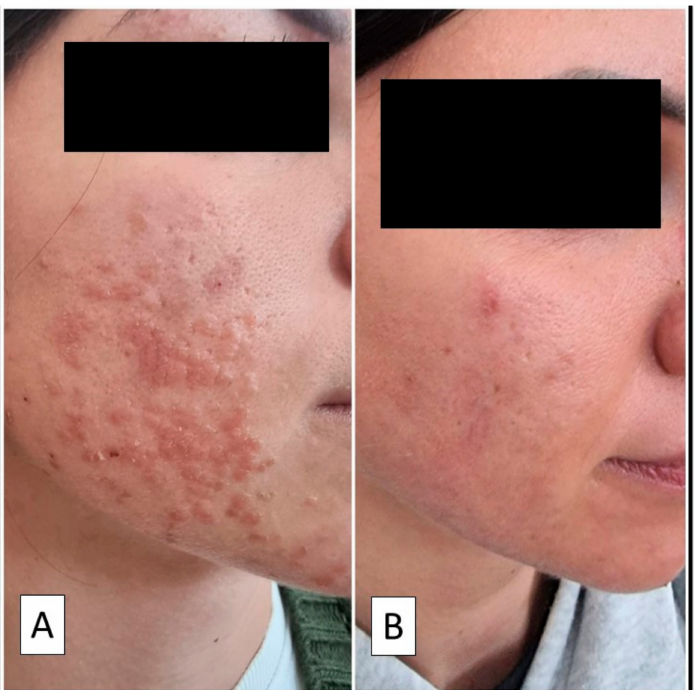
Figure 1. ( A ) Clinical photograph showing papular lesions, partly confluent in plaques, on the cheeks. ( B ) Almost complete remission of the lesions after two peeling sessions with 60% salicylic acid. The sample was fixed in neutral formaldehyde buffered at 10% and sent to the Com- plex Operative Unit of Anatomy and Pathological Histology of the same hospital. After sampling, processing, microtome cutting and drying under a hood, preparations stained with hematoxylin/eosin were prepared and observed under an optical microscope. Histo- logically, a zone of acanthosis with hypergranulosis (Figure 2A) was evident, with a subtle, undulating surface change rather than the prominent finger-like papillomatosis of verruca vulgaris (Figure 2B). The morphological diagnosis of flat warts was